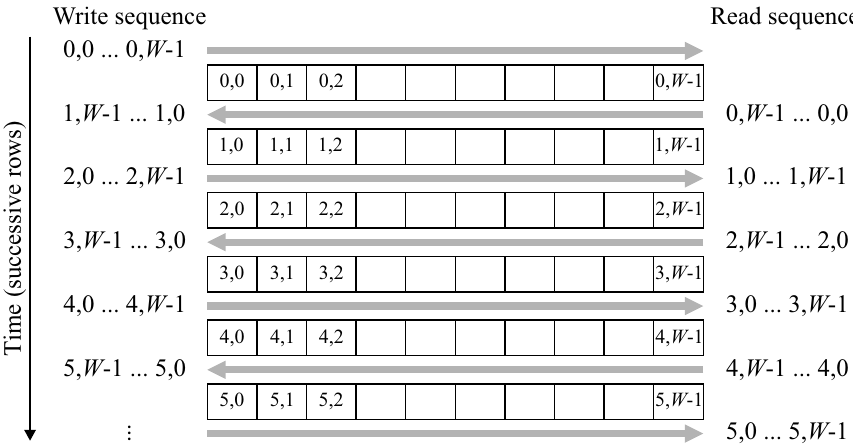
Figure 7. Operation of the zig-zag reordering buffer. Positions in the figure are shown in the format y , x , where y refers to the row and x to the column the pixel was assigned.